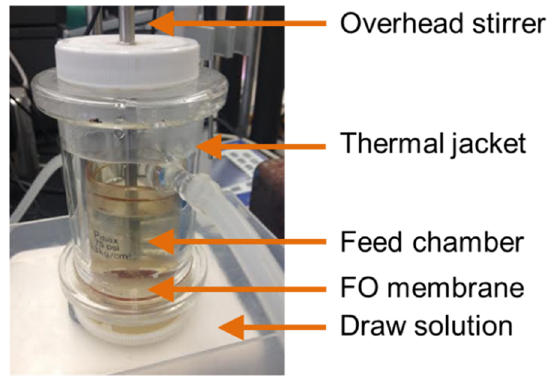
Figure 1. Forward osmosis apparatus for concentration of stick water.